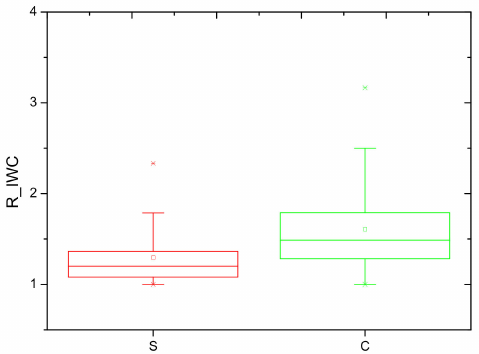
Figure 9. Statistics of R _ IWC in the stratiform cloudregion and the convective cloud region. Table 3. Statistical information for R _ IWC of the stratiform region and the convective region. Cloud Mean